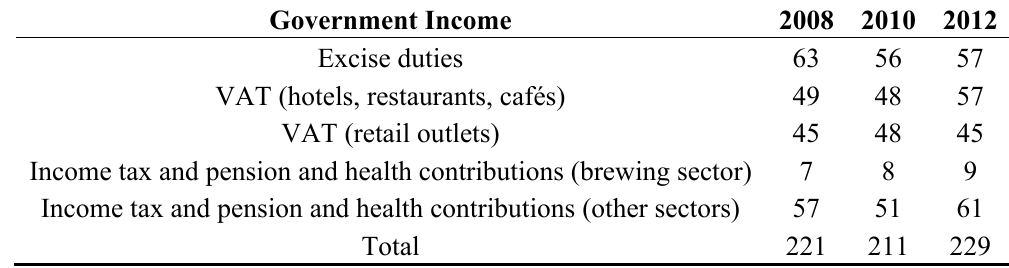
Table 3. Income to the state budget from the production and sale of beer in Euros million— chosen